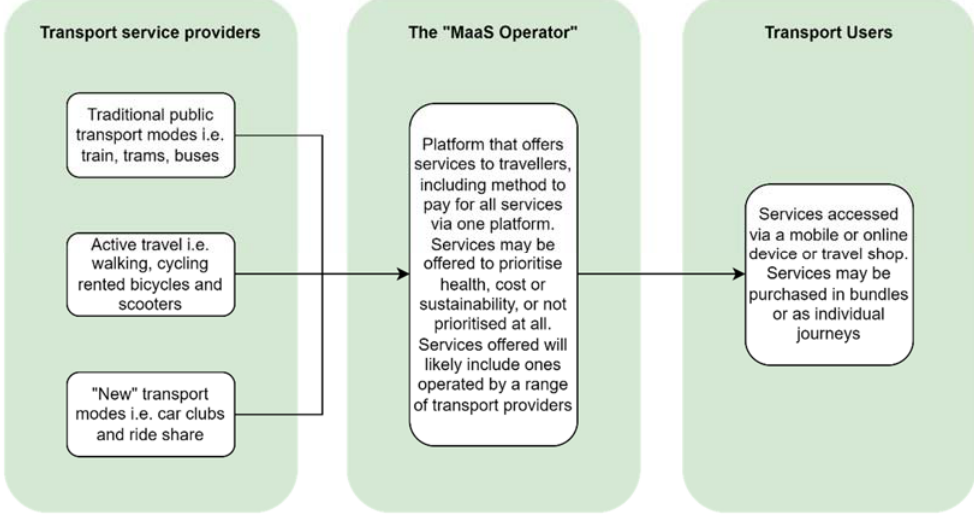
Figure 1. A simple representation of what a MaaS system may contain. (Source: author).